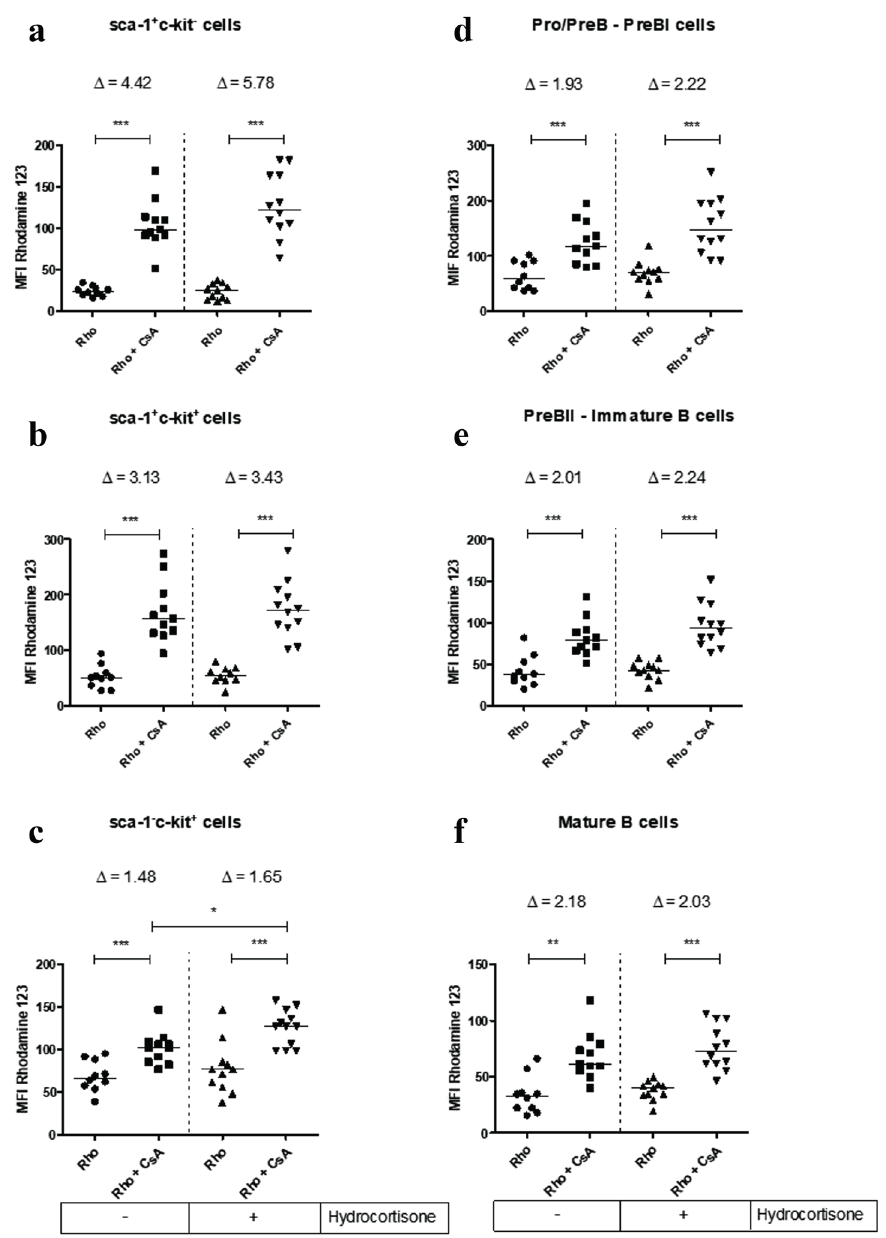
Figure 6 - Effect of in vivo treatment with hydrocortisone on ABCB1 efflux activity of subsets of bone marrow cells. Mice were injected with diluent or hydrocortisone (70 mg/kg/day) for 3 consecutive days. In the next day, mice were injected with cyclosporin A (CsA, 100 mg/kg) and, one hour later, with Rhodamine 123 (Rho, 2.5 mg/kg), as described in materials and methods. Bone marrow cells were counted and stained with monoclonal antibodies for c-kit, sca-1 and B220 molecules for analysis by flow cytometry. ( a ) Median fluorescence intensity for Rho on sca-1+c-kit-, ( b ) sca-1+c-kit+, ( c ) sca-1-c-kit+, ( d ) Pro/PreB - PreBI, ( e ) PreBII - immature B and ( f ) mature B cells. Line represents the median, values represent mean of transport reversal index (Δ=MFI Rho+CsA/MFI Rho), (*) represents values of p < 0.05, (**) p < 0.01 and (***) p < 0.001, according to the statistical test. Results are representative of 4 independent experiments with 2-3 mice/group